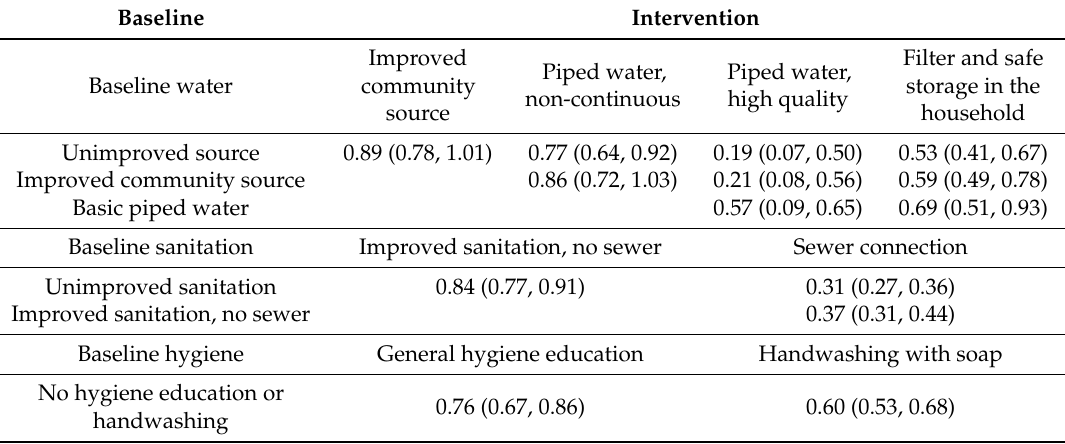
Table 4. Meta-regression results for water and sanitation interventions: relative risks of diarrhea compared with no improved water, sanitation, or hygiene practice (95% confidence intervals in